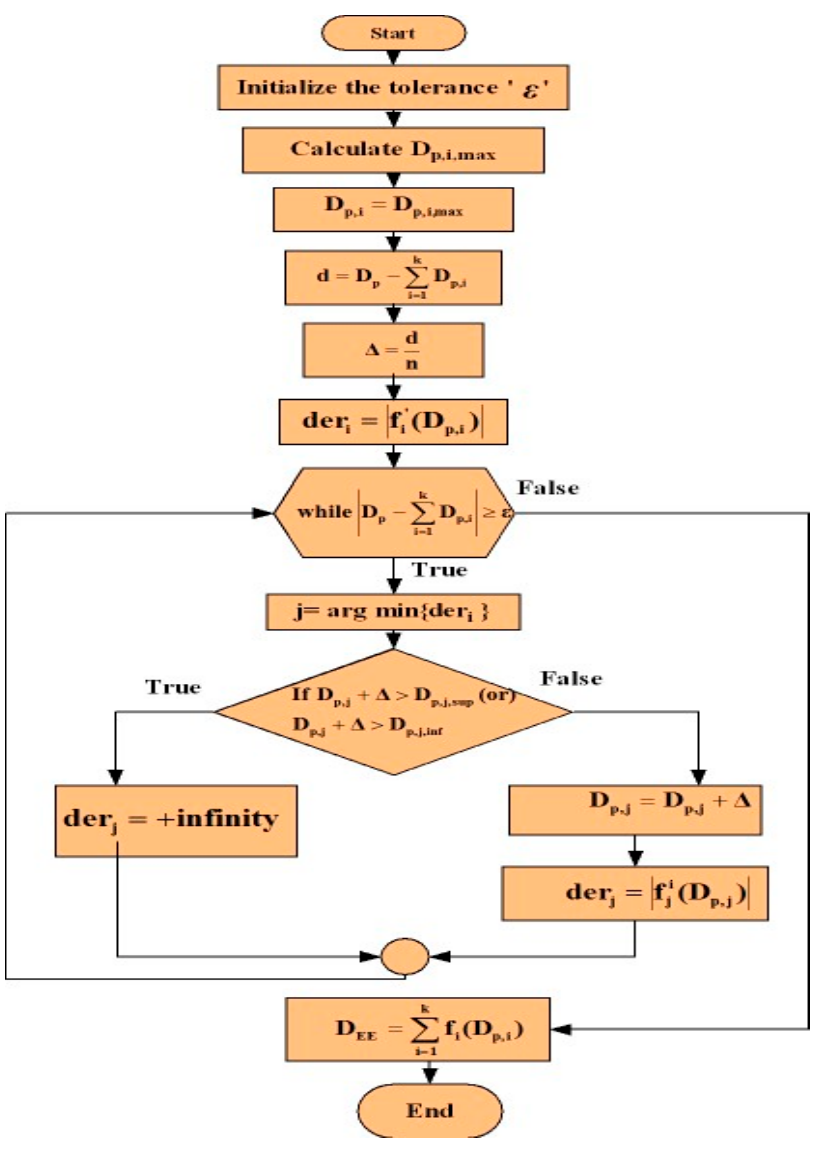
Figure 2. Flow chart for the proposed modified derivative